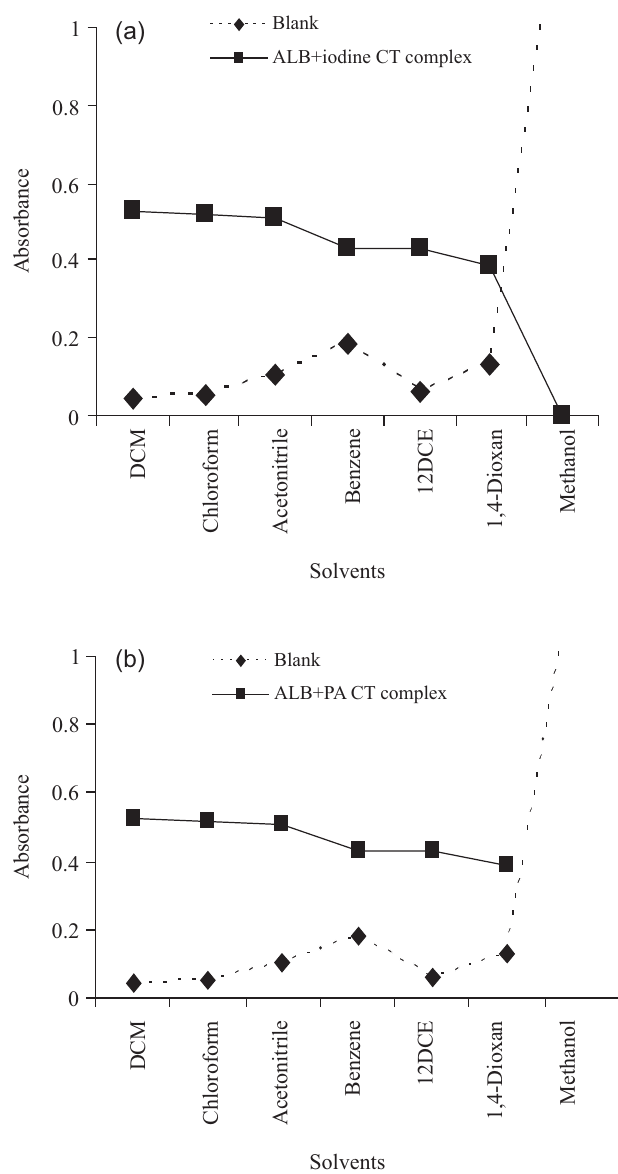
FIGURE 6 - (a) Effect of solvent for method A (120 µg mL -1 ALB); (b) Effect of solvent for method B (30 µg mL -1 ALB).